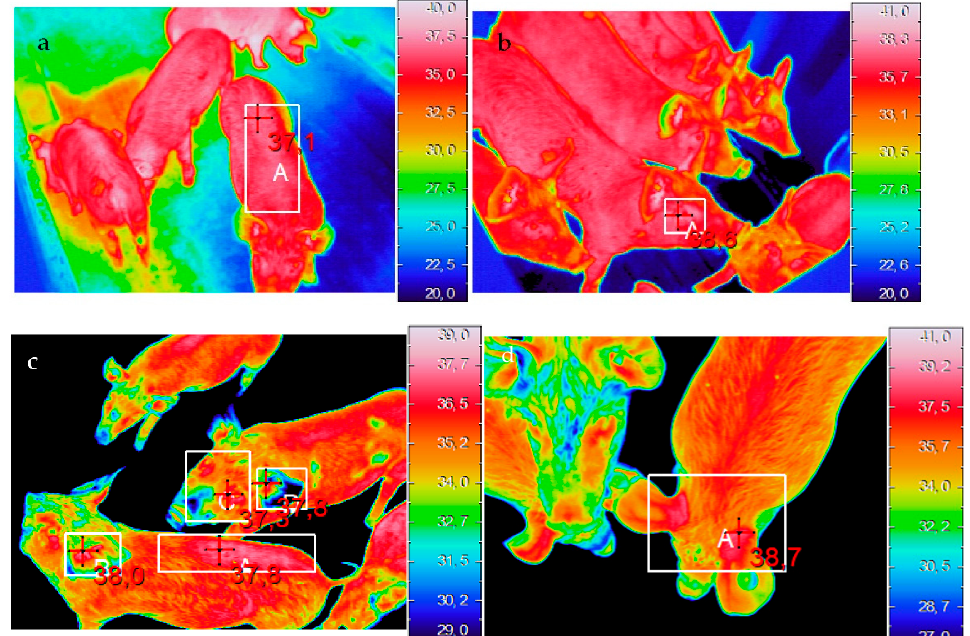
Figure 1. Examples of thermal images of the dorsal ( a ), ocular ( b ), front ear ( c ) and back ear ( d ) regions. The white rectangles indicate the areas in which the maximum temperatures were recorded.